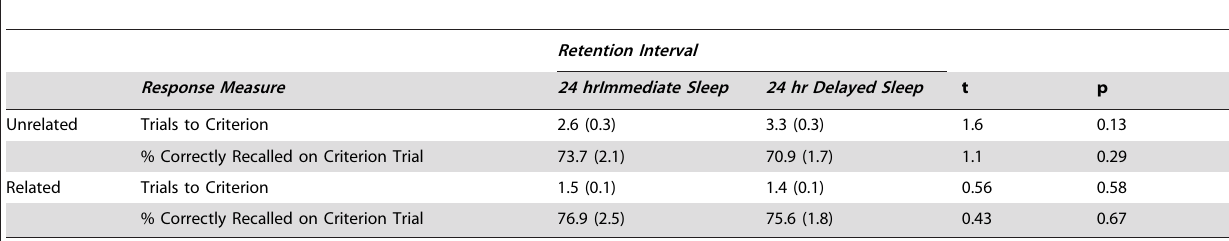
Note: Values are means with SEM in parentheses. Note that across all three experiments, training in the morning ( Wake, 30 min am and 24 hr am groups ) did not differ from training in the evening ( Sleep, 30 min pm and 24 hr pm groups ) on the number of trials it took to reach the 60% criterion or % correct responses on the final (i.e.